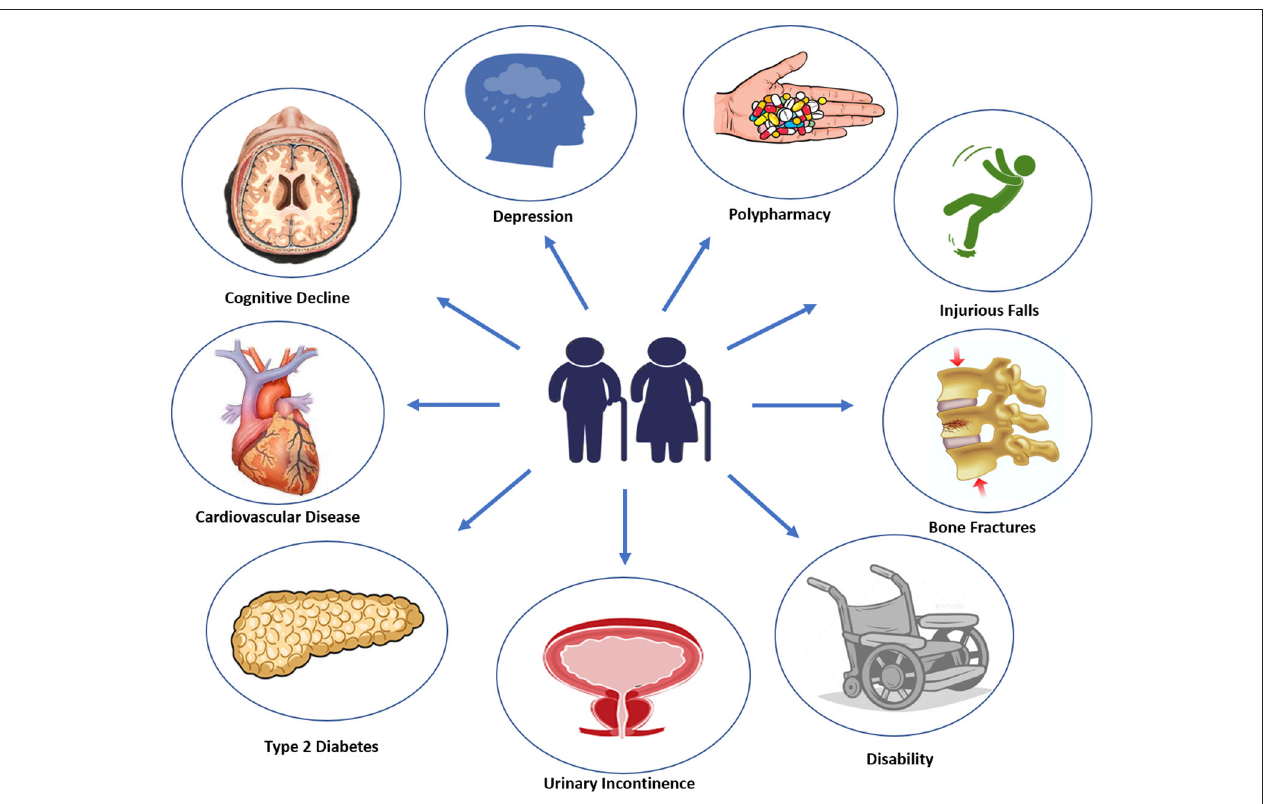
FIGURE 1 | Most common clinical conditions associated with